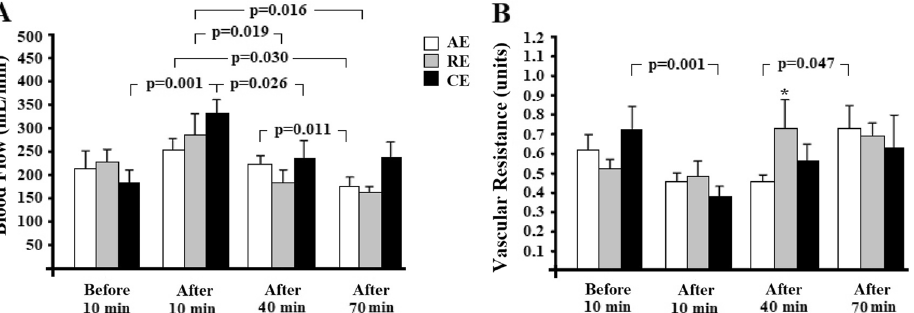
Figure 3. Blood flow response ( A ), vascular resistance ( B ) of the arm at baseline and after exercise intervention in participants with hypertension. AE: aerobic exercise session (n = 11); RE: resistance exercise session (n = 11); CE: combined exercise session (n = 10). Values are expressed as mean ± standard error. GEE with Bonferroni post-hoc test was used and considered differences for p < 0.05. Panel A : p (group) = 0.543, p (time) < 0.001, and p (interaction) < 0.001; Panel B : p (group) = 0.890, p (time) < 0.001, and p (interaction) = 0.024; * versus AE at the same time point.